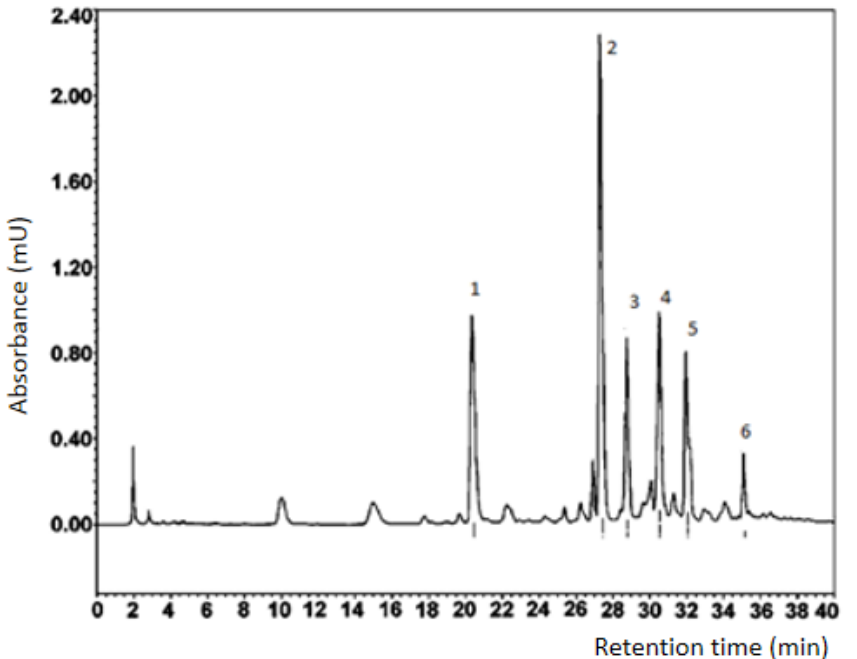
Figure 1. Results of preparative separation of the ecdysteroid fraction of in vitro callus, cell sus- pension, and root cultures of Rhaponticum carthamoides .